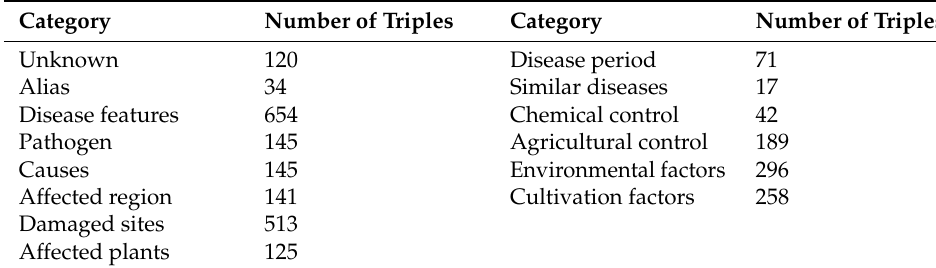
Figure 7. An example of relation labeling. Example “ 番茄细菌性斑疹病的农业防治方法主要有加强 检疫、防止带菌种子传入非疫区 ” (this means that the agricultural prevention and control methods of tomato bacterial leaf spot mainly include strengthening quarantine and preventing the introduc- tion of bacterial seeds into non-epidemic areas). Table 2. Relation categories.